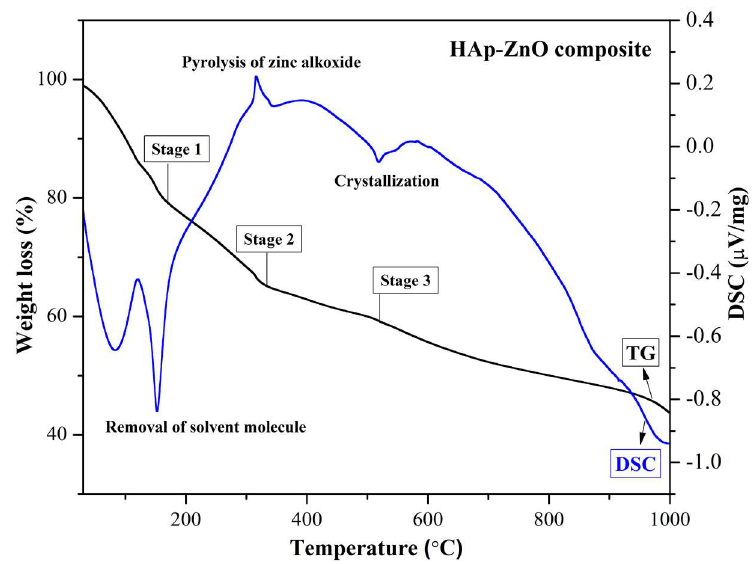
Figure 3. TG/DSC graph of HAp-ZnO composite.